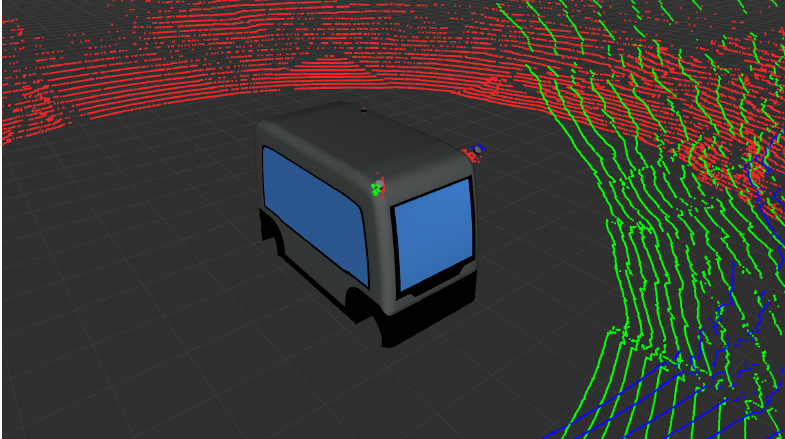
Figure 12. LiDAR points that hit the ego